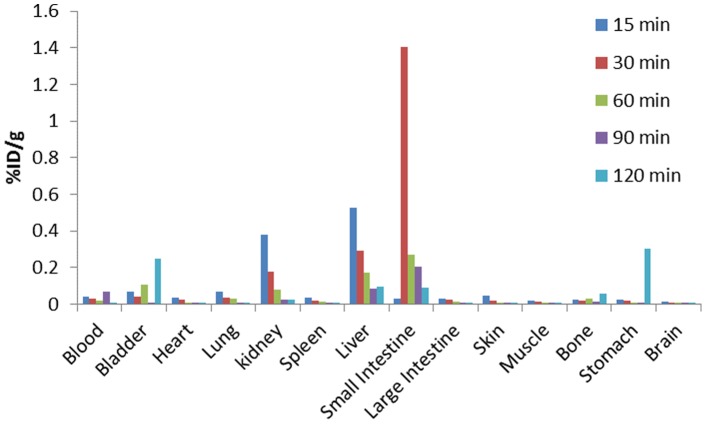

Ex vivo analysis of the distribution of [18F]FBuEA-GS 3 in a rat.